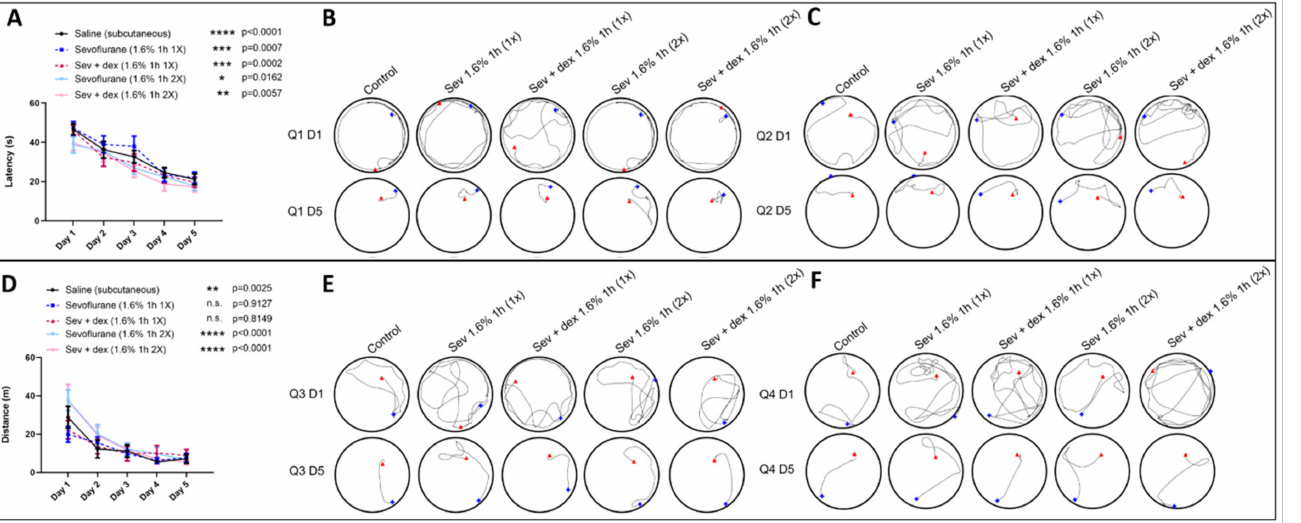
Figure 3. DEX pre-treatment resulted in less anxious, erratic, and indecisive swimming patterns. ( A ) Average latency and ( D ) average swimming distance between the four quadrants needed per day to reach the hidden platform. Swimming tracing patterns for days 1 and 5 in quadrants ( B ) 1, ( C ) 2, ( E ) 3 and ( F ) 4. Control (animals injected with saline). Bars indicate mean ± SEM ( A ) F (16,220) = 0.3397, **** p < 0.0001, and ( D ) F (16,220) = 0.9185, **** p < 0.0001 using